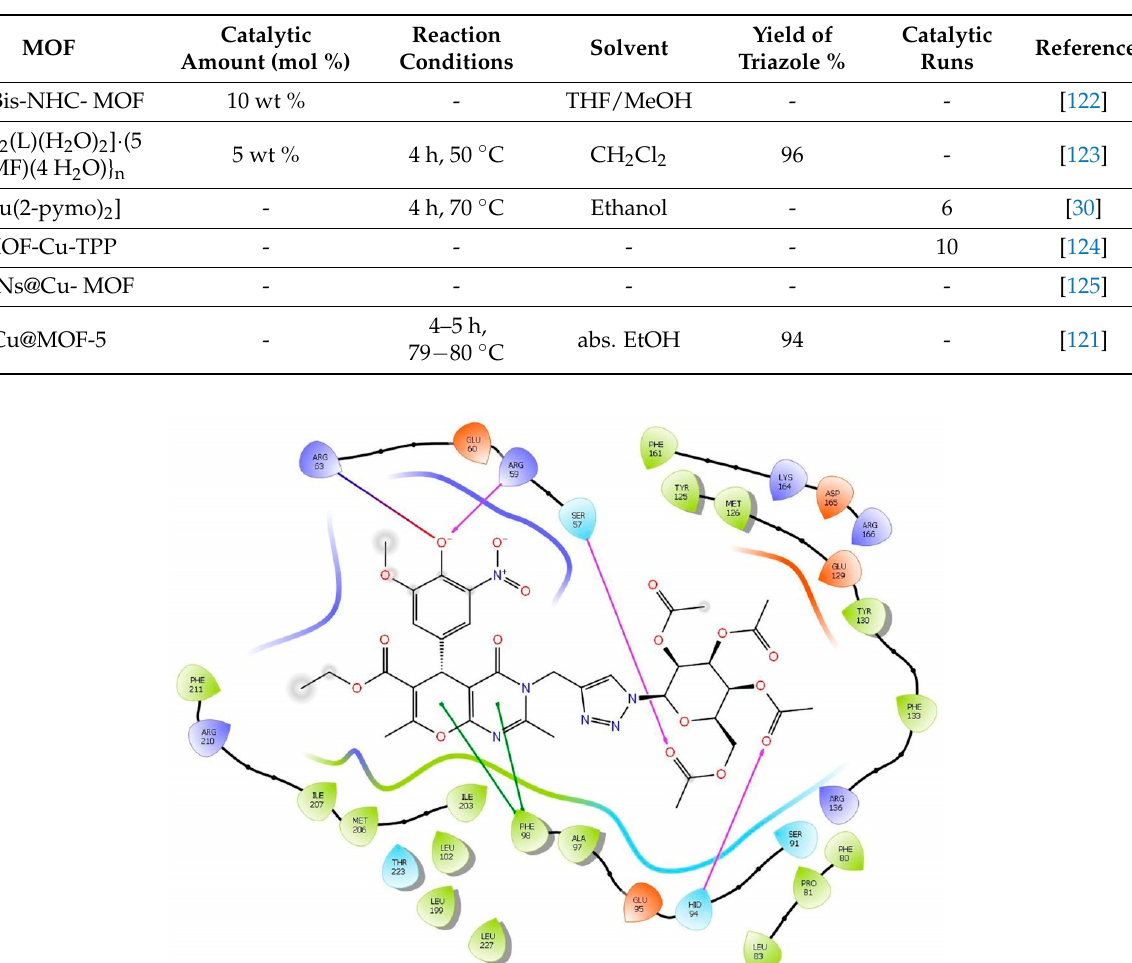
Table 7. Copper-based MOFs for the synthesis of 1,2,3-triazole via the CuAAC reaction.